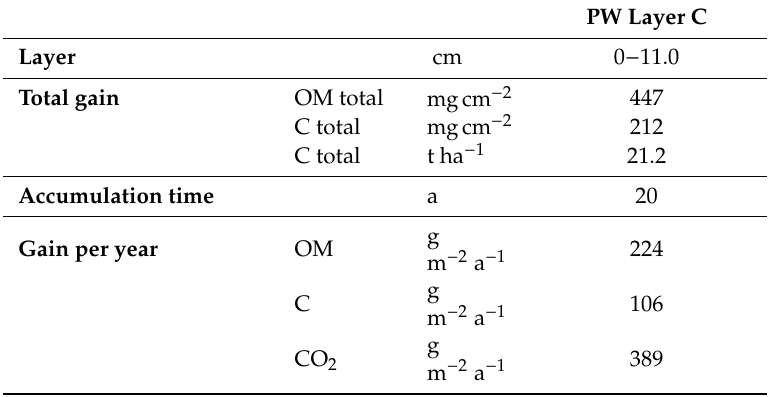
Table 6. Gains of OM and C and correspondingly bound CO 2 in PW layer C